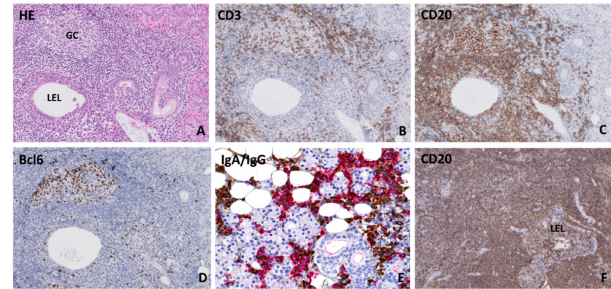
Figure 1. Histopathological features in parotid salivary glands of primary Sjögren’s syndrome patients ( A ) Lymphocytic infiltrate located around a hyperplastic striated duct (lymphoepithelial lesion: